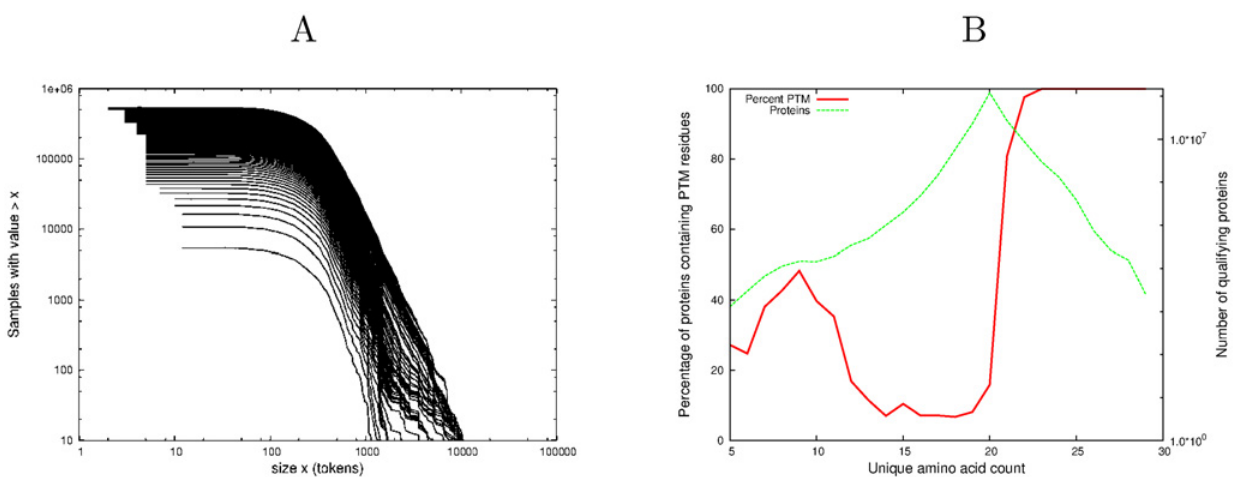
Fig 5. Persistency and PTM occurrence rate. A Cumulative distribution function plots of length distribution for increasingly large random subsets of the proteins present in SwissProt illustrating that power-law behaviour is persistent. B The percentage of proteins which contain PTM amino acids, and the number of proteins, as a function of unique amino acid